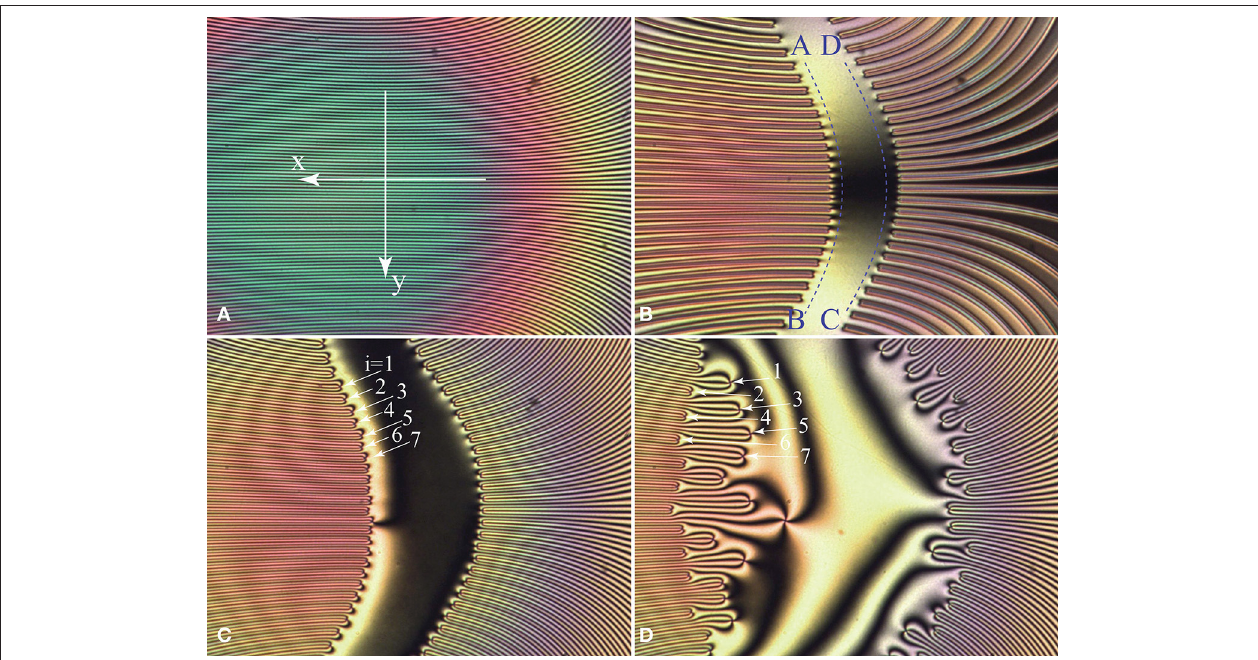
FIGURE 6 | Dowsons race. (A) Central portion of the dowser texture wound up in the DDC. It can be seen as a stack of 2 π walls. (B) Collective generation of (d + ,d − ) pairs by application of a transient shear flow (in y direction) which “breaks” simultaneously all 2 π walls. (C) At the beginning of the race, dowsons d + (or d − ) are moving with the same velocity. (D) Odd-even instability: odd dowsons (i = 2n+1) stay behind even dowsons (i = 2n) because they become about three times slower. (Collaboration with Elise Hadjefstatiou and Lisa-Marie